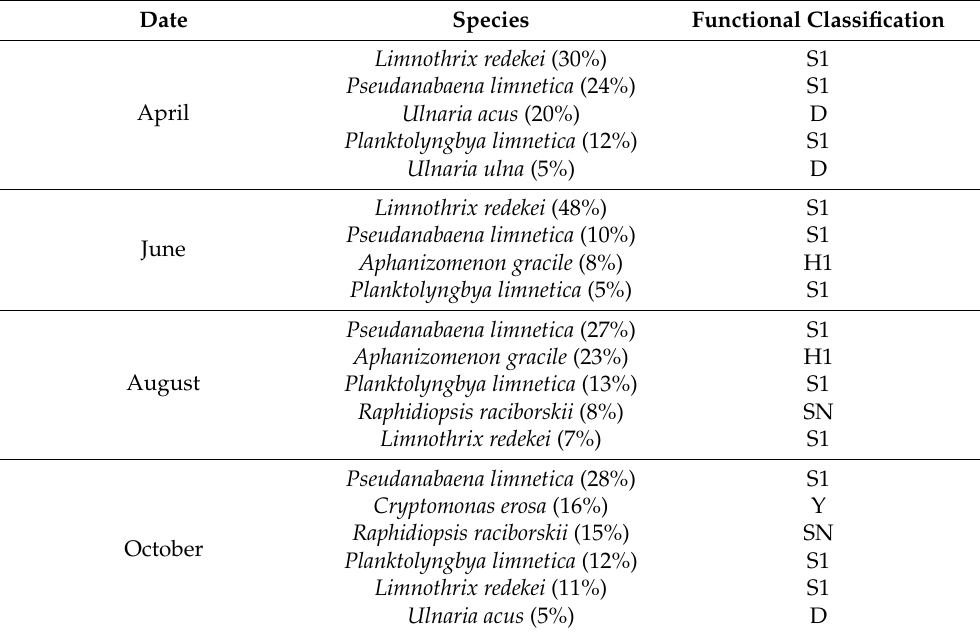
Table 1. Dominant species ( ≥ 5% of total biomass) in phytoplankton of Lake Sztynorckie during the whole growth season of